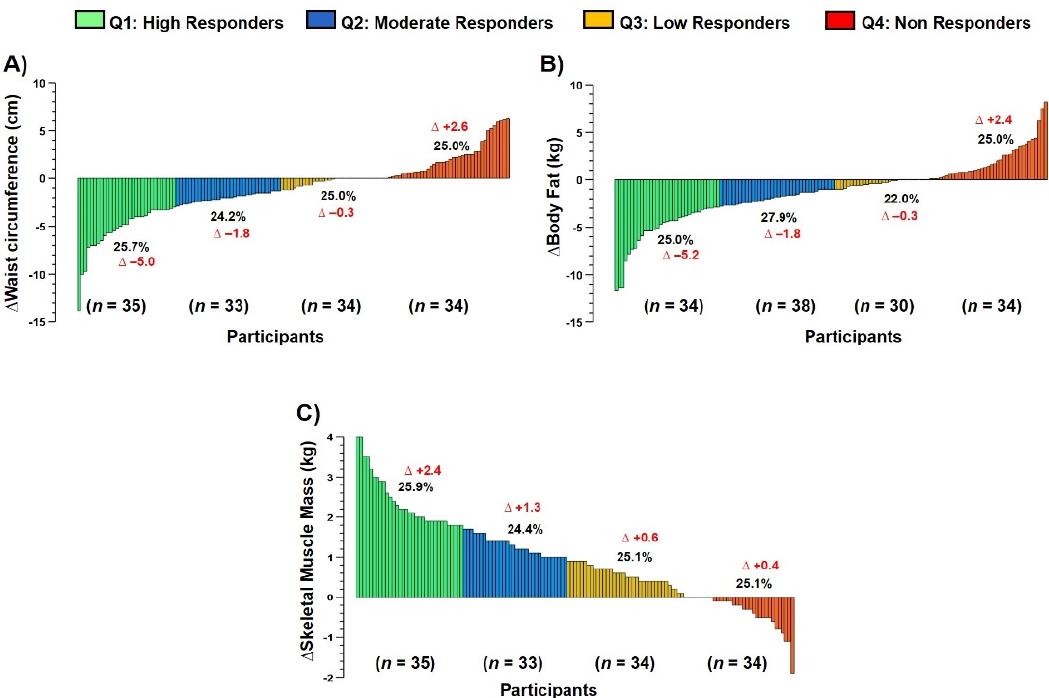
Figure 3. Interindividual variability to anthropometric/body composition outcomes (panel ( A )) waist circumference, (panel ( B )) body fat, and (panel ( C )) skeletal muscle mass after a comprehensive outpatient cardiovascular rehabilitation program based on concurrent exercise training.